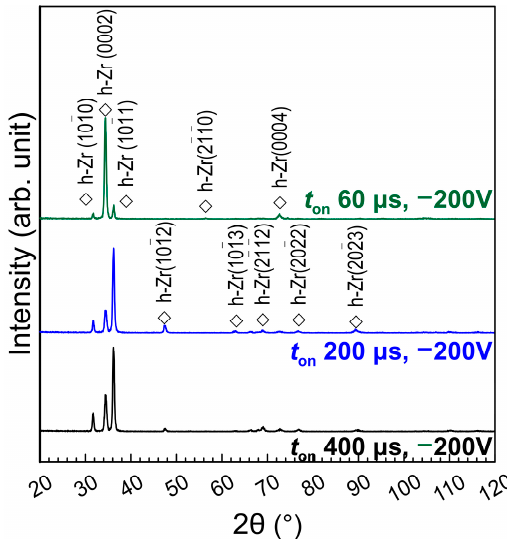
Figure 6. X-ray diffractograms of Zr films deposited at an argon pressure of 1.2 Pa and pulsed subscheme 200. V with different HiPIMS pulse widths ( t on ).